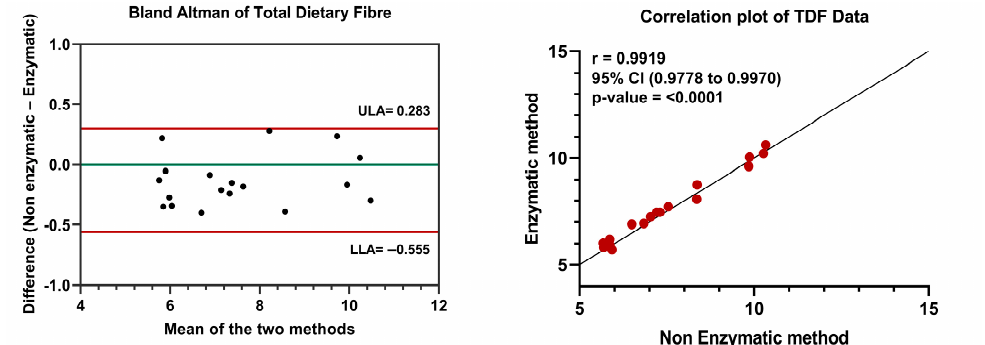
Figure 3. Comparison of TDF data from enzymatic and non-enzymatic methods. Bland–Altman plot was created by plotting the average and difference between the enzymatic and non-enzymatic methods. ULA—Upper limit of agreement; LLA—Lower limit of agreement. Pearson’s correlation coefficient was calculated for IDF data. Statistical significance was set at p -value ≤ 0.05.